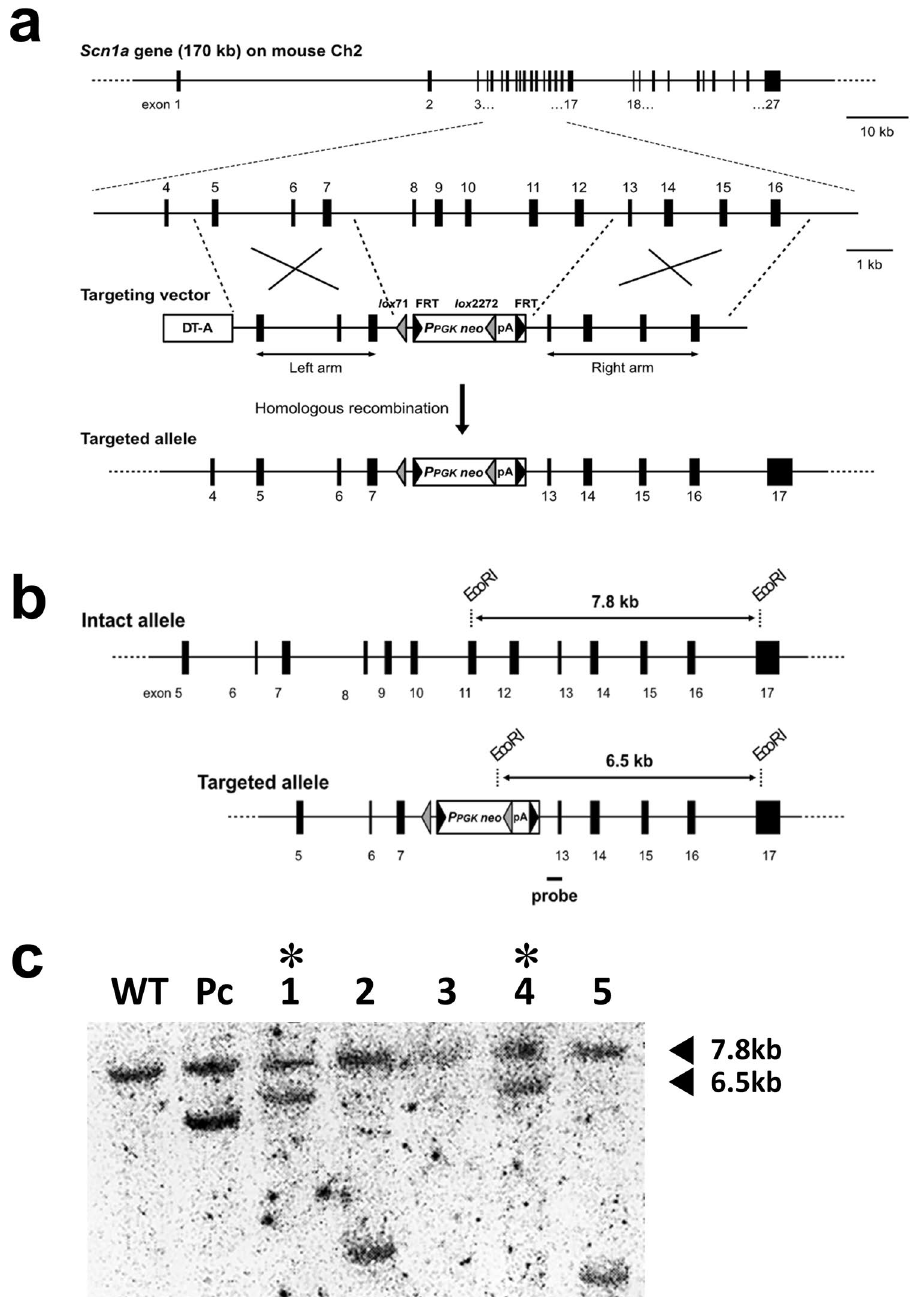
Figure 1. Targeting of the Scn1a gene in mouse embryonic stem cells. ( a ) Strategy for Scn1a targeting. Upper, overall schematic view of the mouse Scn1a gene, and a magnified view containing the targeted region from exons 8 to 12. Exons are shown as numbered solid boxes, and introns are shown as horizontal lines. Middle, the organization of the targeting vector. More detail is indicated in the Materials and Methods. Shaded and solid triangles indicate the lox and flippase recognition target sequence (FRT) elements, respectively. Regions to be recombined between genomic Scn1a and the targeting vector are indicated by large Xs. Bottom, the targeted Scn1a allele that resulted from desirable homologous recombination. ( b ) Comparison of the restriction patterns of wild-type and targeted Scn1a alleles in Southern analysis. The position of the hybridization probe is indicated by a solid bar. ( c ) A result of Southern hybridization for seven candidate clones. For samples #1 and #4, both the 7.8- and 6.5-kb fragments were detected, which were derived from the wild-type and homologously recombined Scn1a